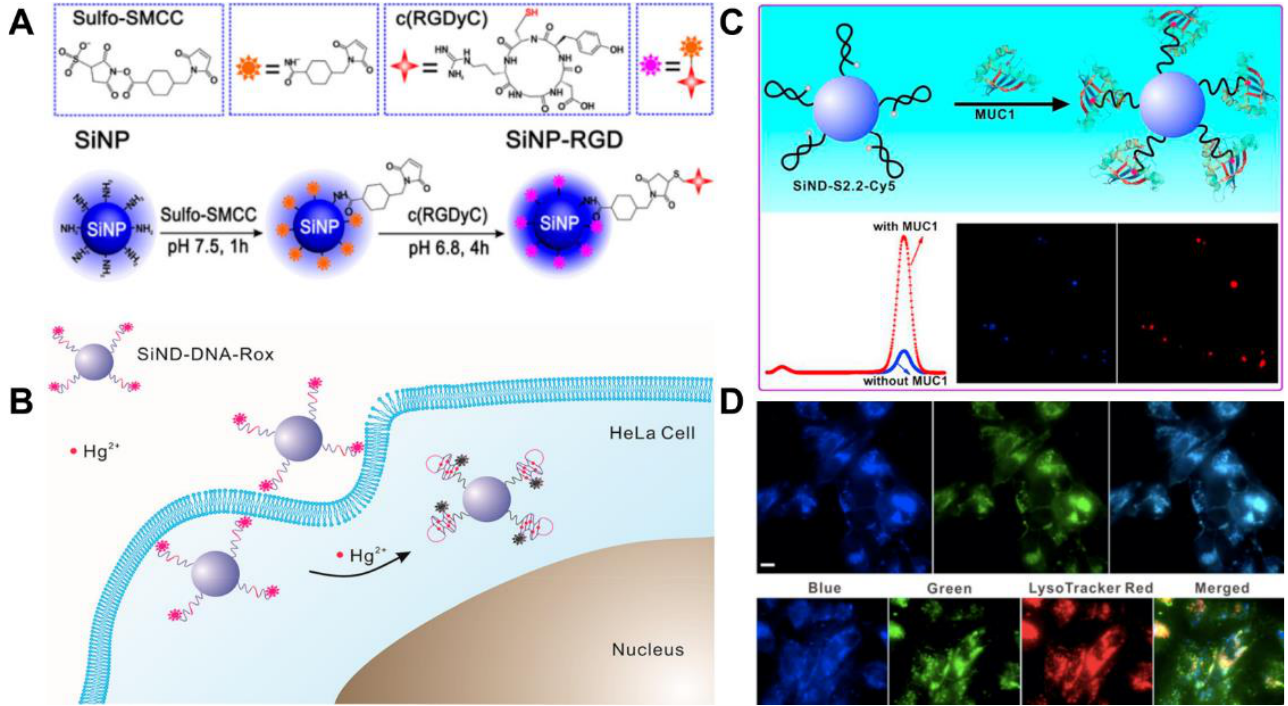
Figure 6. ( A ) Schematic synthesis of the SiNPs-RGD. Reproduced from [79], with permission from American Chemical Society, 2015. ( B ) Schematic presentation of the SiND-DNA-Rox sensor for the ratiometric detection of Hg 2+ in HeLa cell. Reproduced from [70], with permission from American Chemical Society, 2018. ( C ) Schematic presentation of the SiND-S2.2-Cy5 aptasensor for the detection and bioimaging of MUC1. Reproduced from [75], with permission from Elsevier, 2018. ( D ) photoluminescent images of MCF-7 cells (Top row) incubated with SiNDs-Apt-FAM (from left to right: blue channel, green channel, merged), and photoluminescent images of MCF-7 cells (bottom row) incubated with SiNDs-Apt-FAM and LysoTracker Red DND-99 (from left to right: blue channel, green channel, red channel, merged). Scale bars: 20 µm. Reproduced from [71], with permission from Elsevier, 2017.